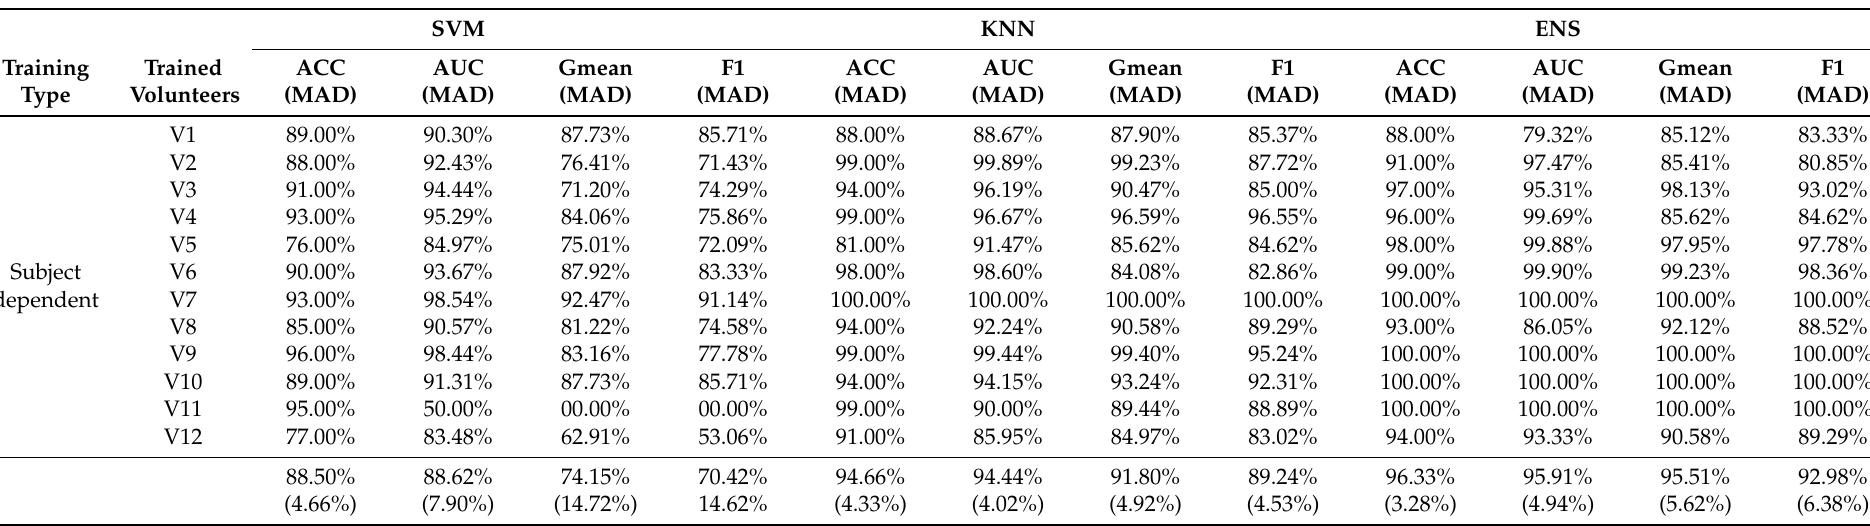
Table 2. Performance metrics for each generated subject-dependent model and average performance metrics and dispersion for each classification algorithm. SVM: support vector machine; KNN: k-nearest neighbor; ENS: ensemble classifiers; MAD: mean absolute deviation; ACC: accuracy; AUC: area under the